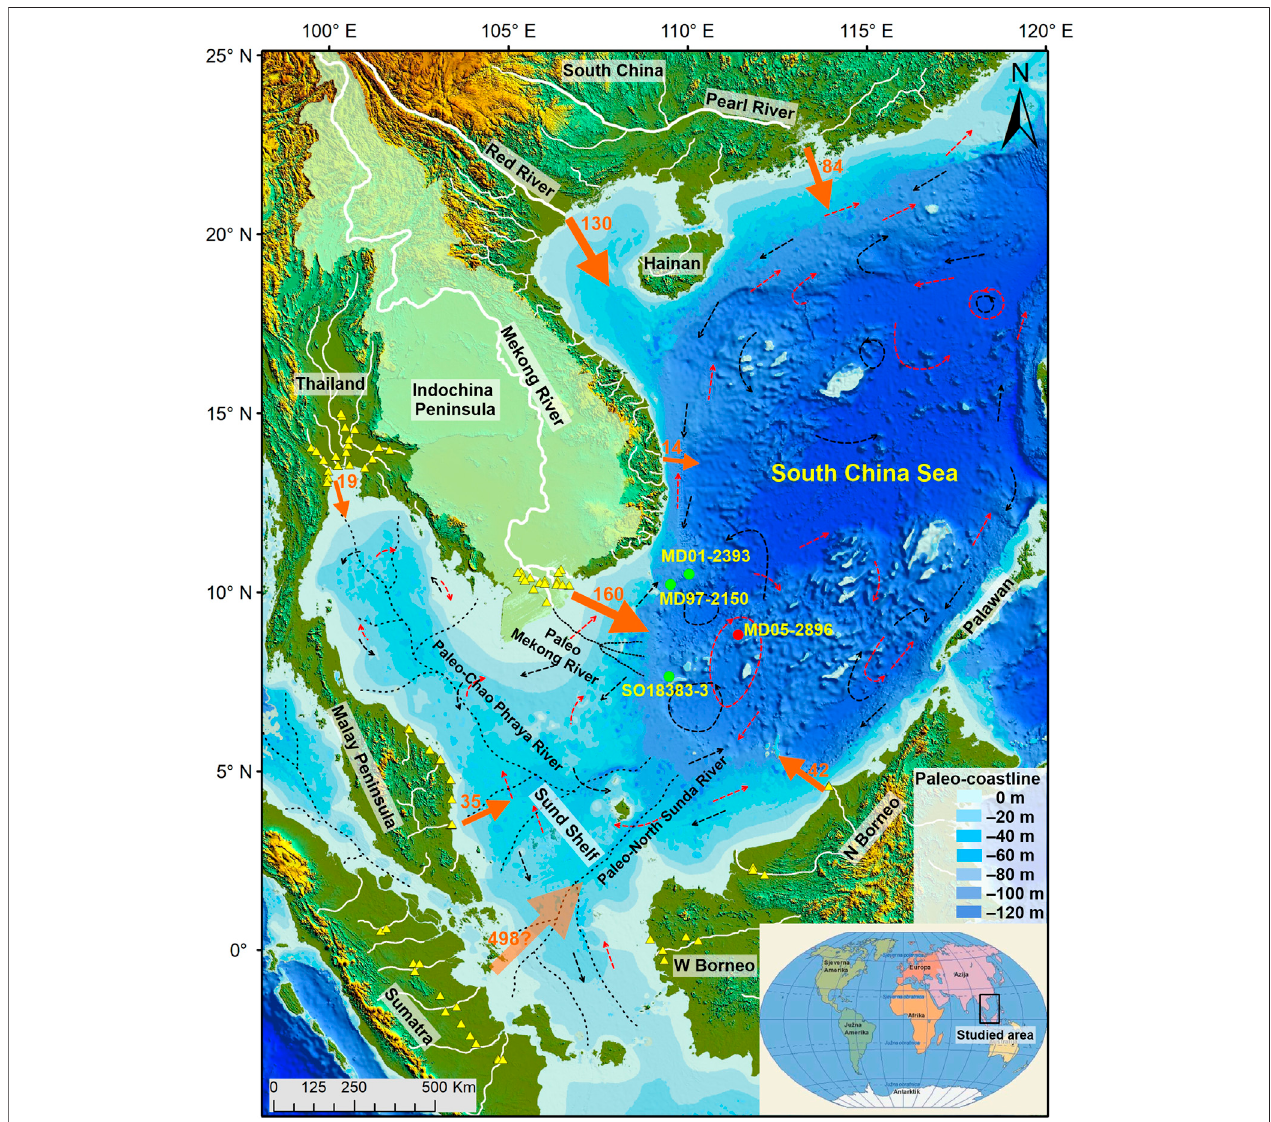
FIGURE 1 | Topographic map of Southeast Asia displaying the location of Core MD05-2896 (red circle) in the southern South China Sea. Referred cores (green circles) and surrounding river samples (yellow triangles) are also indicated. Orange arrows with numbers show annual suspended sediment discharge (Mt/yr). Dotted arrows present surface current systems in winter (black) and summer (red) following (Liu and Stattegger, 2014, Liu et al., 2016). Paleo-coastlines are plotted based on present-day bathymetric depth contours (Hanebuth et al., 2011; Tjallingii et al., 2014). Paleo-river systems are displayed according to Voris (2000) and Sathiamurthy and Voris